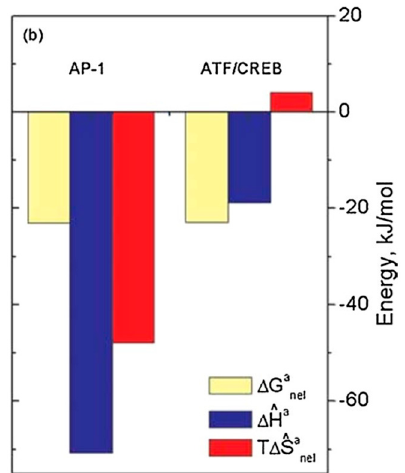
Figure 7. The enthalpic ( ∆ H a , blue) and non-electrostatic entropy factor ( T ∆ S a , red) contributions to the non-electrostatic Gibbs energy of association ( ∆ G a nel , cream) of the fully folded and crosslinked GCN4 bZIP homodimer binding to the AP-1 and ATF/CREB DNA target sites. Reprinted with permission from Ref. [25] copyright 2004 Elsevier.